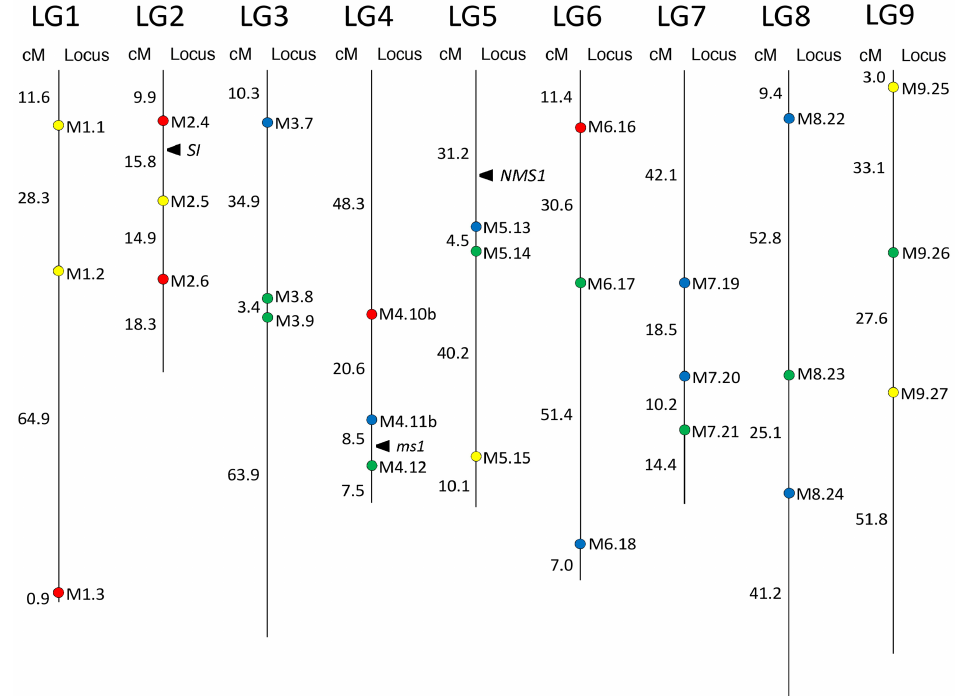
Figure 2. Schematic representation of the nine basic linkage groups of chicory ( Cichorium intybus L.) with indication of the 27 mapped marker loci chosen by Ghedina et al. (2015) to implement a method for genotyping elite breeding stocks. Mutant genes responsible for genetic male-sterility were mapped on linkage group 5 ( NMS1 -locus) and 4 ( ms1 -locus) whereas the S -locus controlling self-incompatibility was mapped on linkage group 2 ( SI ). For details see Cadalen et al. [51], Gonthier et al. [28], and Barcaccia and Tiozzo [31,32].